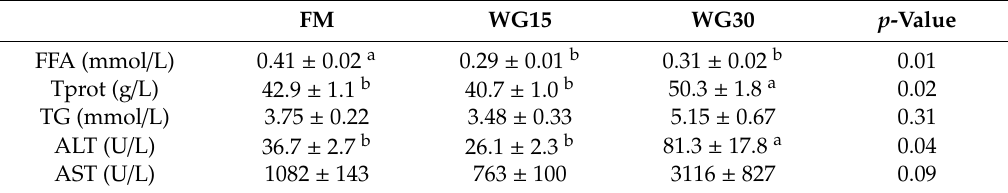
Table 4. Free fatty acids (FFA), total protein (Tprot), triglycerides (TG), alanine aminotransferase (ALT), and aspartate aminotransferase (AST) levels in the serum of salmon fed with FM or WG-containing diets. Data are mean ± S.E.M. ( n = 15; five fish per three replicate tanks). Significant di ff erences ( p < 0.05) between the dietary groups are indicated with di ff erent